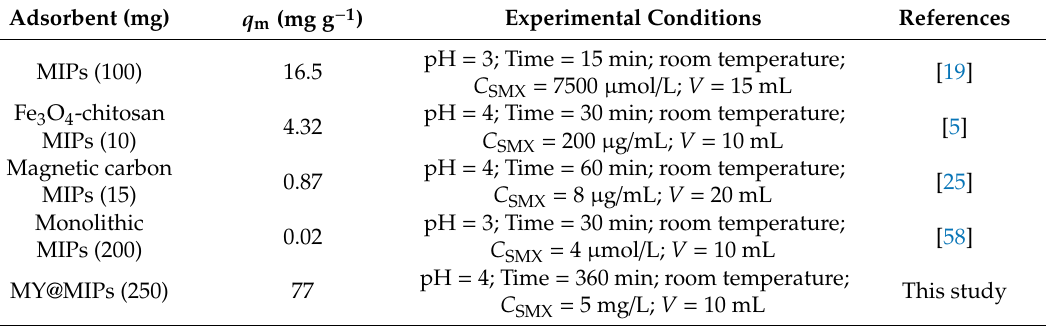
Table 4. Maximum Langmuir adsorption capacities ( q m , mg g − 1 ) of di ff erent MIPs used for the adsorption of